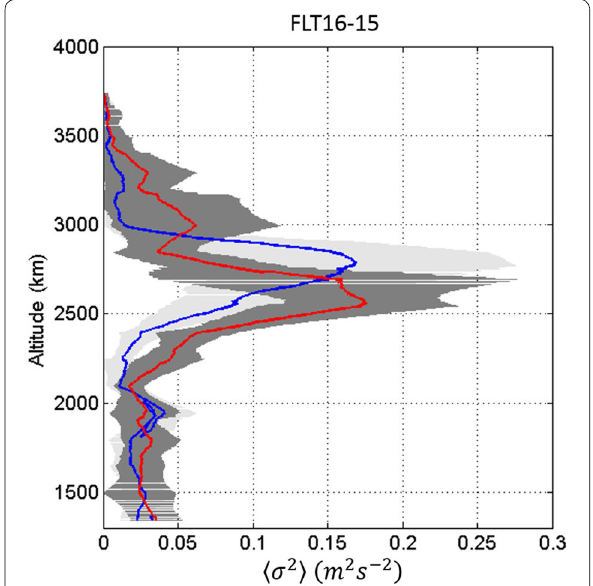
Fig. 2 Example of pseudo-profile of σ 2 calculated according to the procedure shown in Fig. 1 for FLT16-15 A1 (blue) and D1 (red). Light and heavy gray areas show the rms value of σ 2 during the time averaging for A1 and D1, respectively. The zigzag pattern around 2000 m during A1 is due a brief unintended descent of